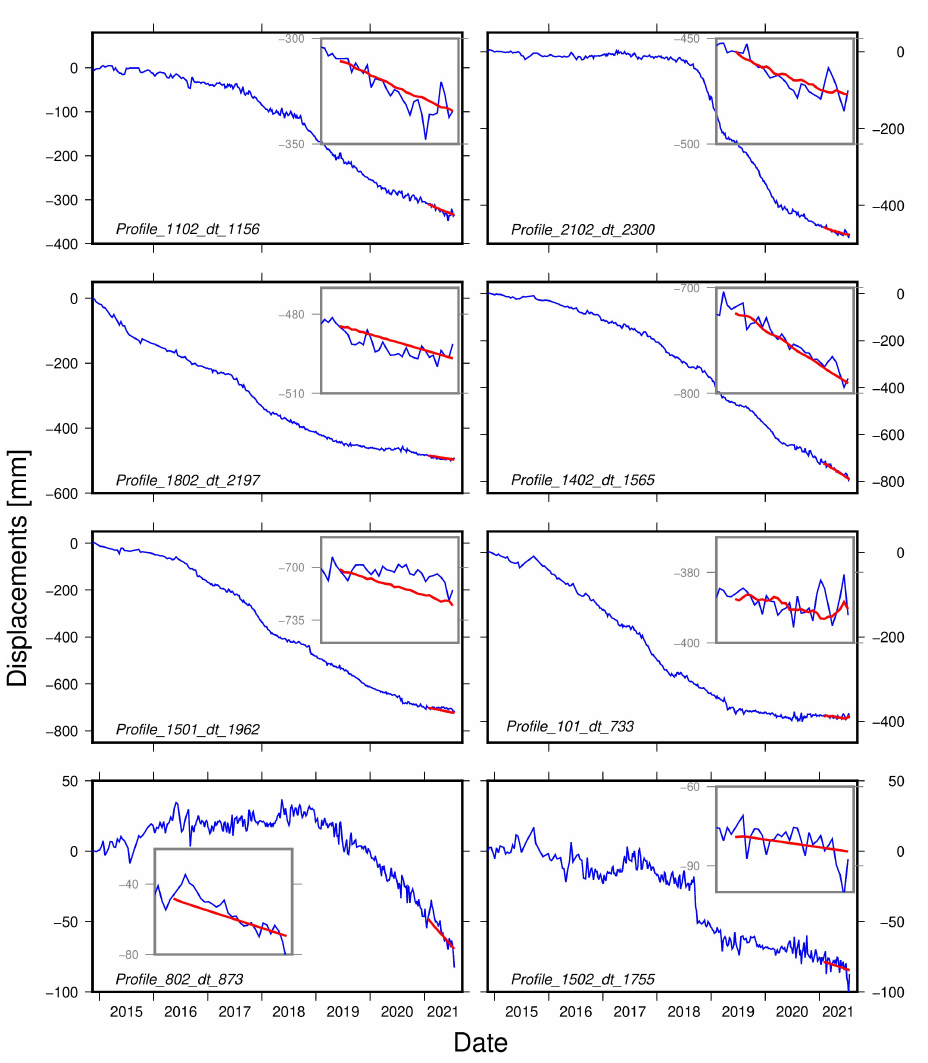
Figure 7. ARIMA forecast results for randomly selected